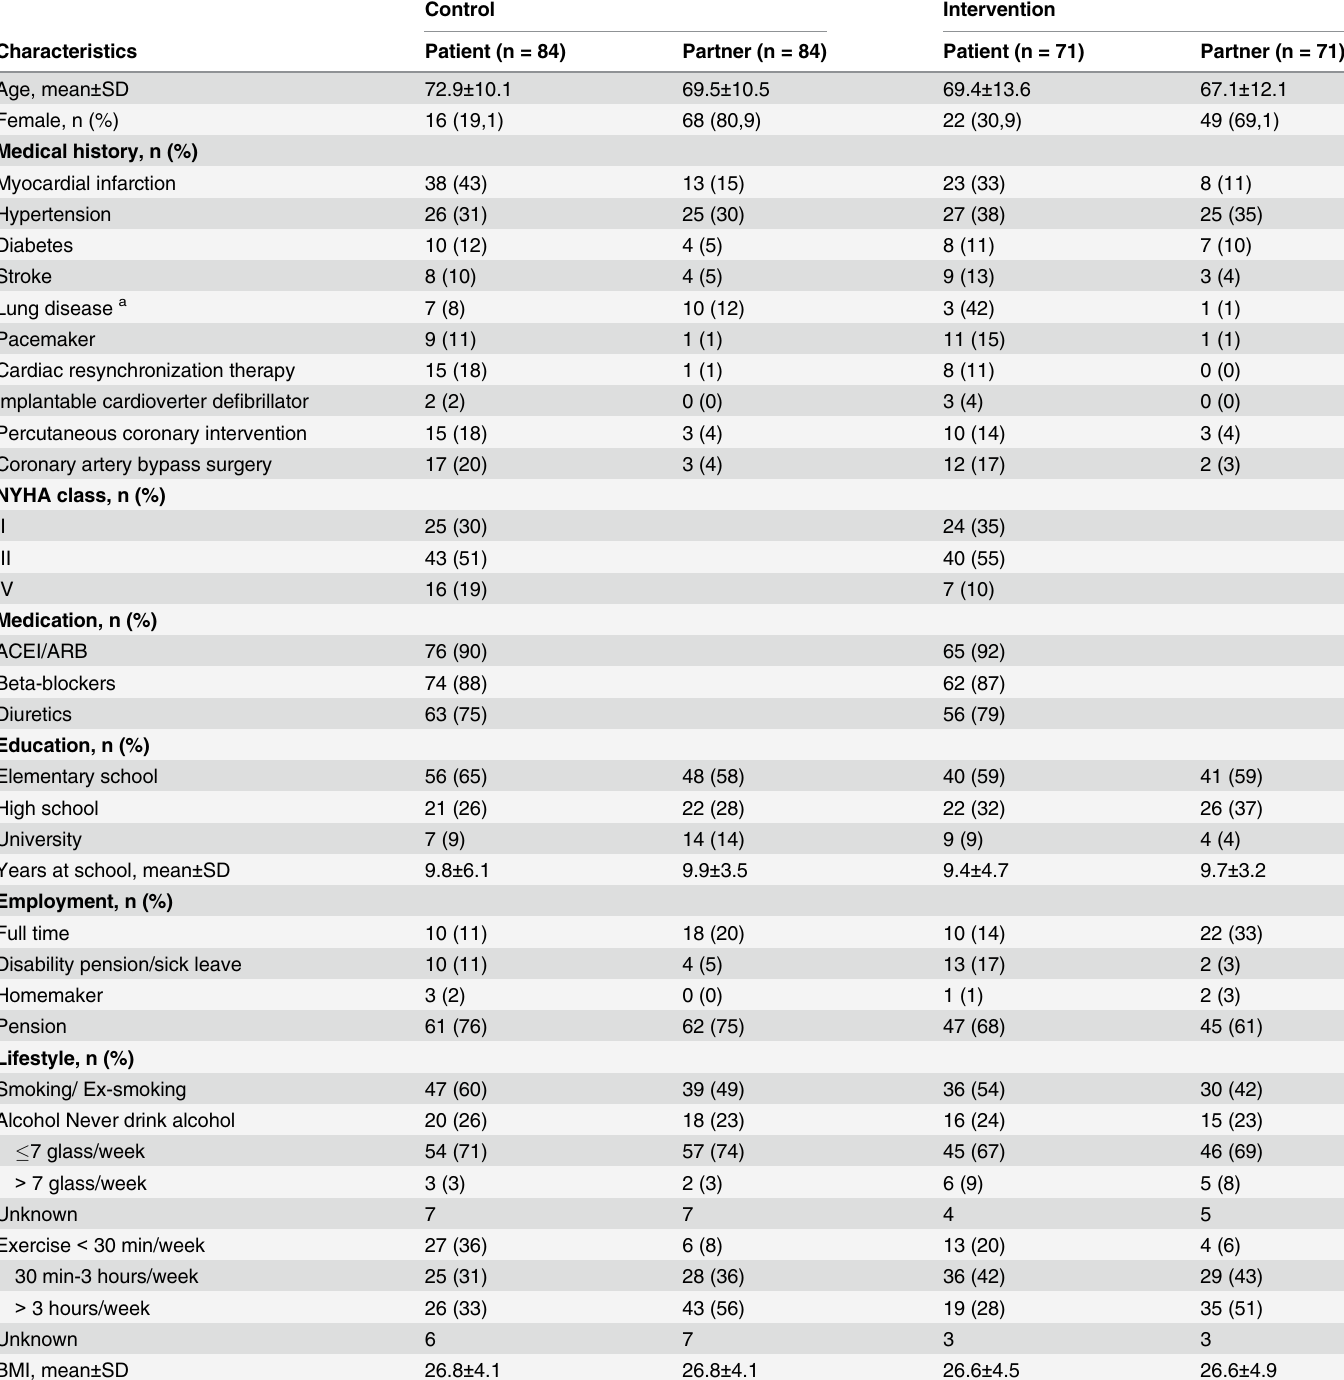
Table 2. Clinical and demographic characteristics of the patient-partner dyads at